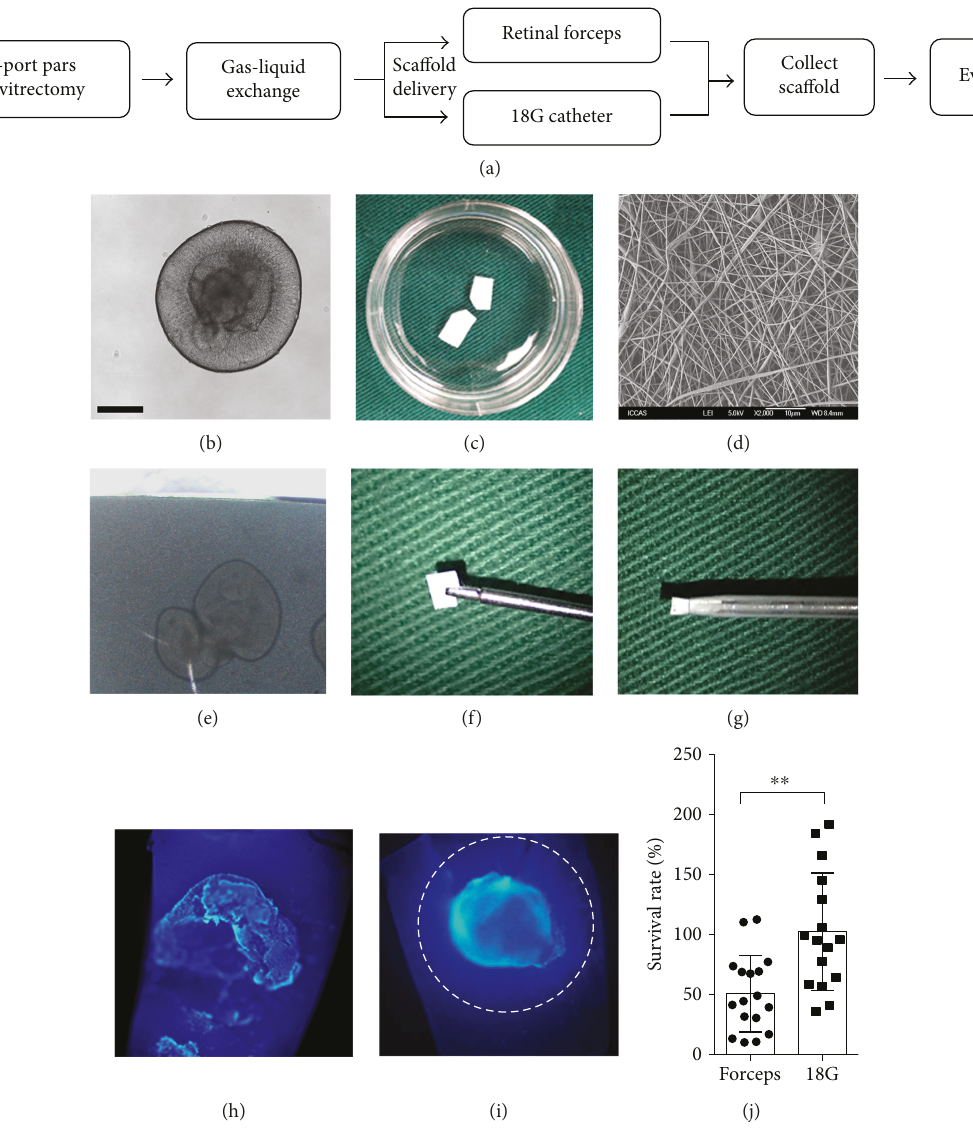
Figure 1: Comparison between the two PLGA sca ff old delivery methods. (a) Surgical procedures with the two di ff erent delivery methods. After gas-liquid exchange, cellular sca ff olds were delivered either by retinal forceps or 18G catheter. (b) Three-dimensional retinal tissue cultured in suspension (scale bar =200 μ m). (c) The degradable PLGA sca ff old in a dish. The size of sca ff old is 2mm ∗ 4 – 8mm, and one corner was cut to label the cellular side. (d) Scanning electron micrographs of the nano fi bers in the PLGA sca ff old, which was prepared by electrospinning. (e) Retinal tissue with progenitors was seeded and cultured onto the PLGA sca ff old in dish. A few days later, the progenitors migrated and spread out from tissue and were directed towards an RGC fate. (f) Cellular PLGA sca ff old delivery by retinal forceps. The sca ff old was rolled up edge to edge to wrap and protect the retinal progenitors from scraping during delivering. (g) The half-loaded PLGA sca ff old in an 18G catheter. After retracting the core, the sca ff old was rolled up and loaded into the catheter. (h) DAPI staining of the cellular sca ff old delivered by retinal forceps showed that the retinal tissue was obviously dashed circle demonstrates the di ff erentiating and migrating progenitors on surface of sca ff old. (j) Comparison of the cell survival